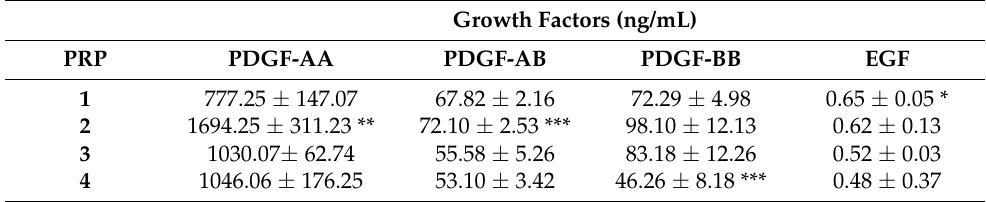
Table 2. PDGF (isoforms AA, BB, AB) and EGF concentrations (ng/mL) in the PRP samples, number of replicates = 4. Values are reported as mean values ± SD (* p < 0.05, ** p < 0.01, *** p <